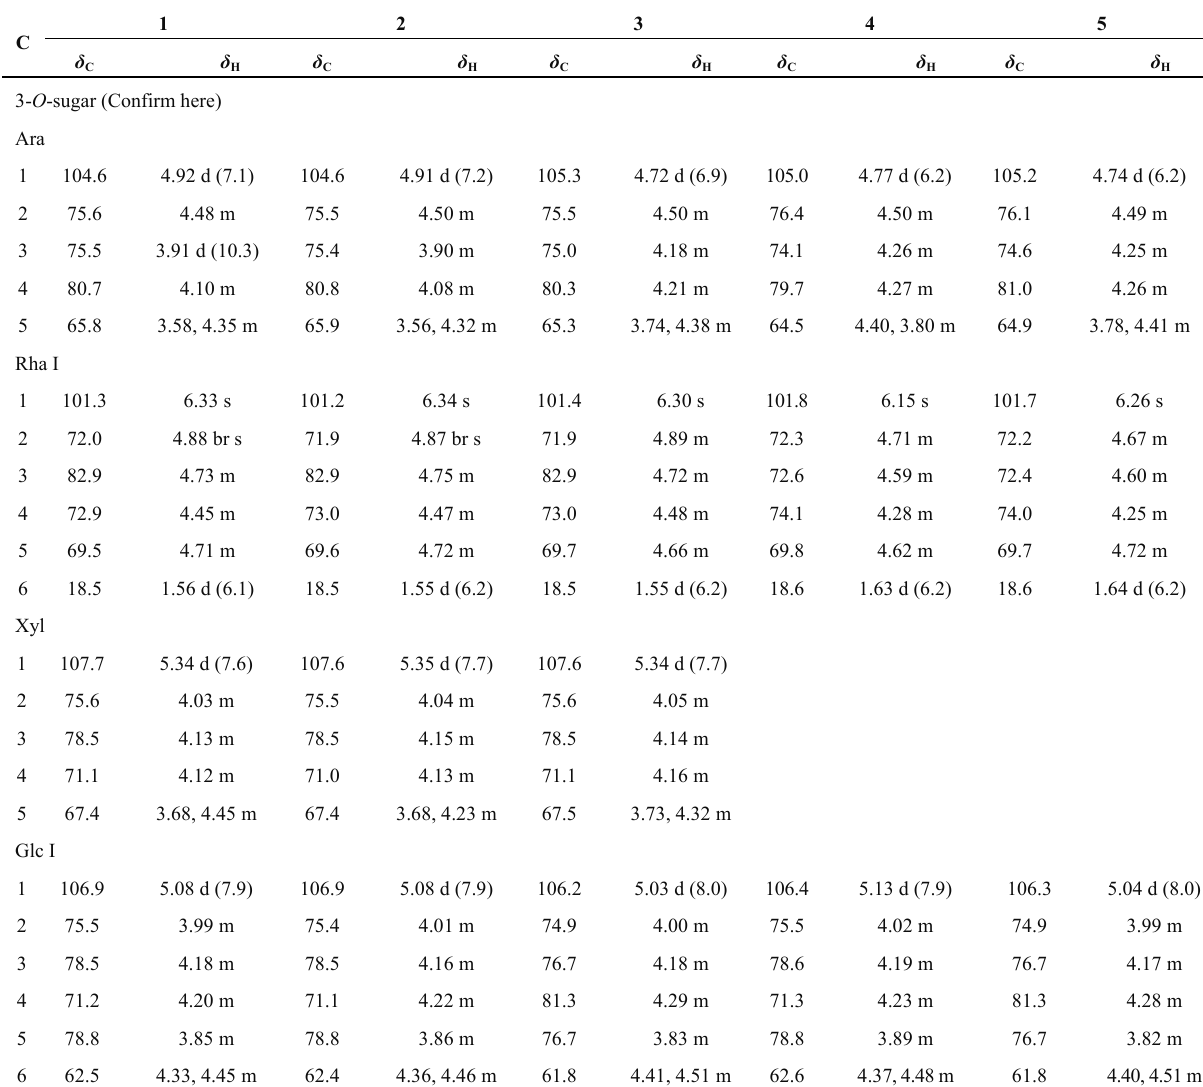
Table 2. 1 H- (500MHz) and 13 C-NMR (125 MHz) chemical shifts assignments for